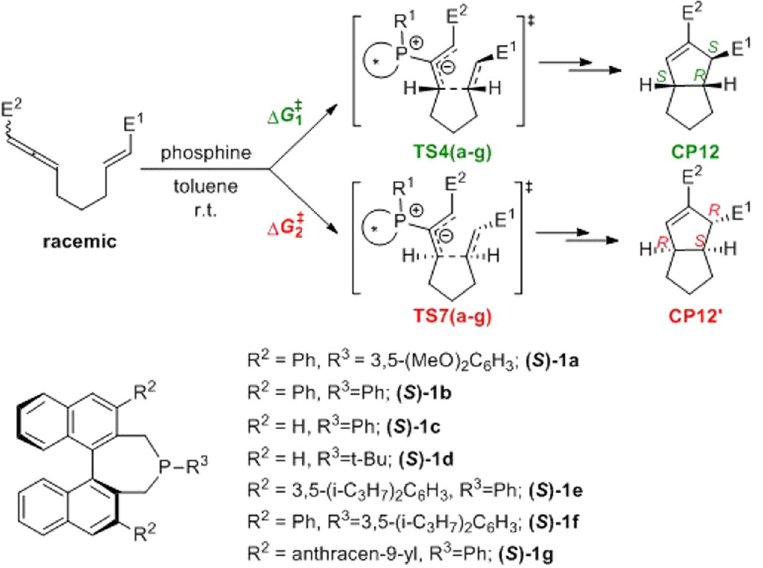
Figure 9. The phosphine catalysts with a series of various